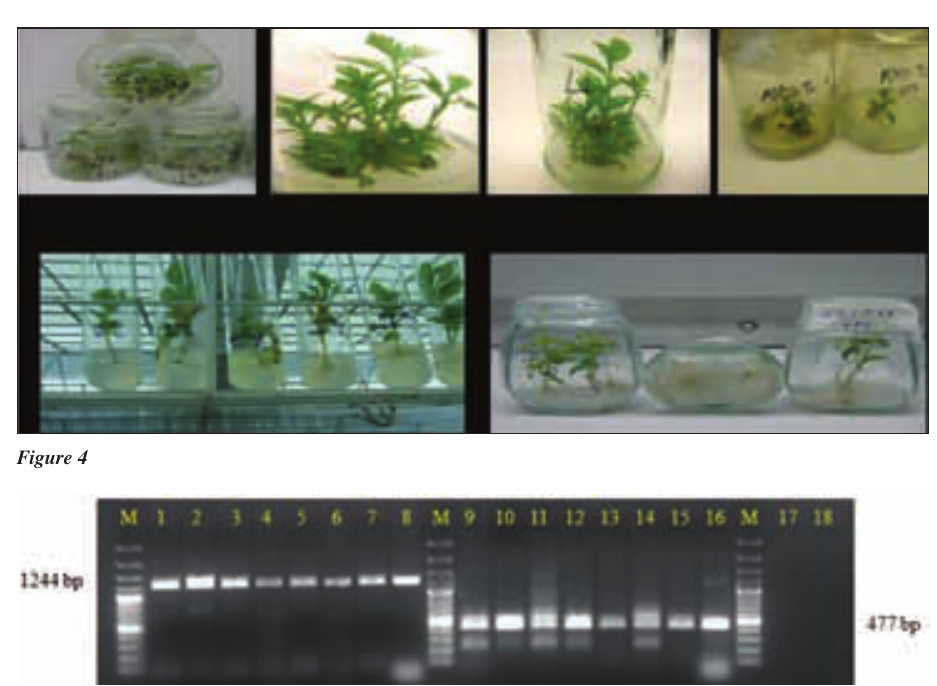
6Figure 5. Molecular Confirmation of Transformation by PCR for the gene of interest g2ps1 and the selection agent bar gene. Lanes: 1,2 GD; 3,4: M26; 5,6: RG, 7: MM111, 8: positive control. Lanes: 9,10: GD; 11,12: M26; 13,14: RG; 15: MM111, 16: positive control; 17: water,18: negative control (DNA isolated from non­transformed apple) M: 100 bp